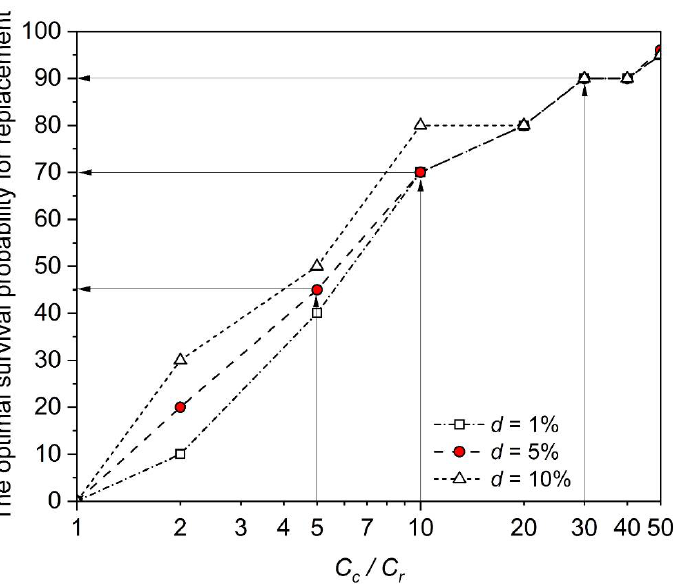
Figure 9. Influences of C c / C r on the optimal survival probability for replacement considering dif- ferent discounted rates.